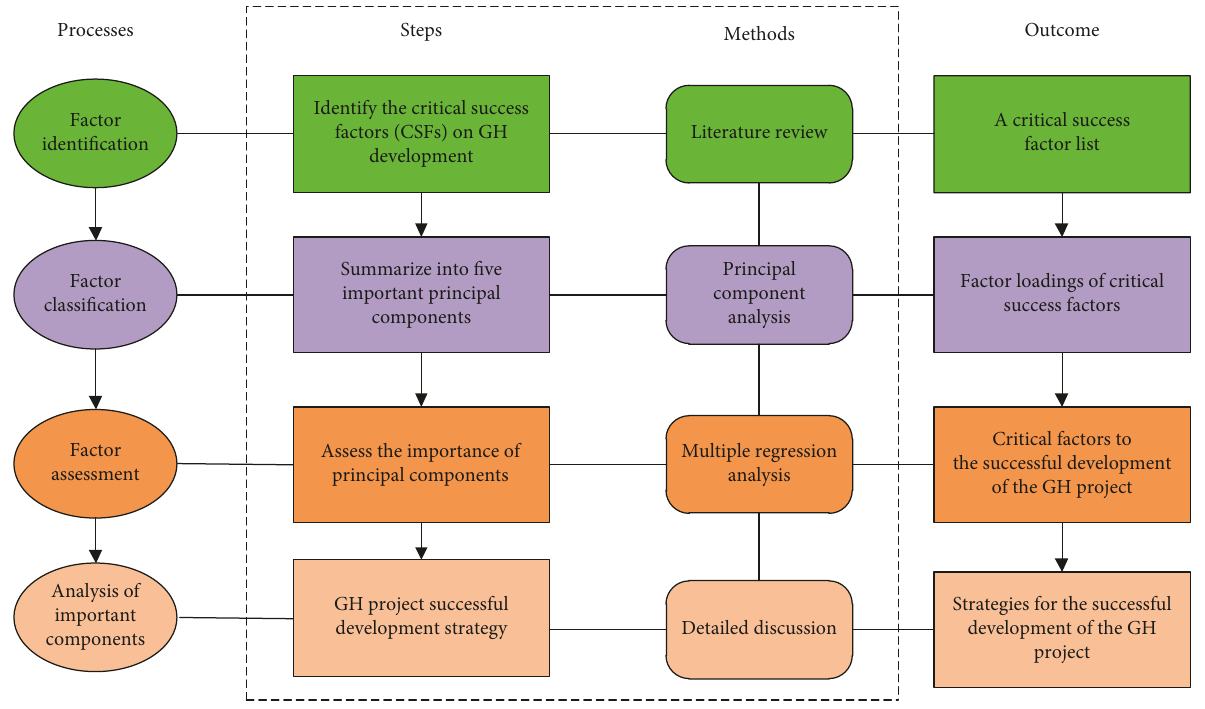
Figure 1: Research